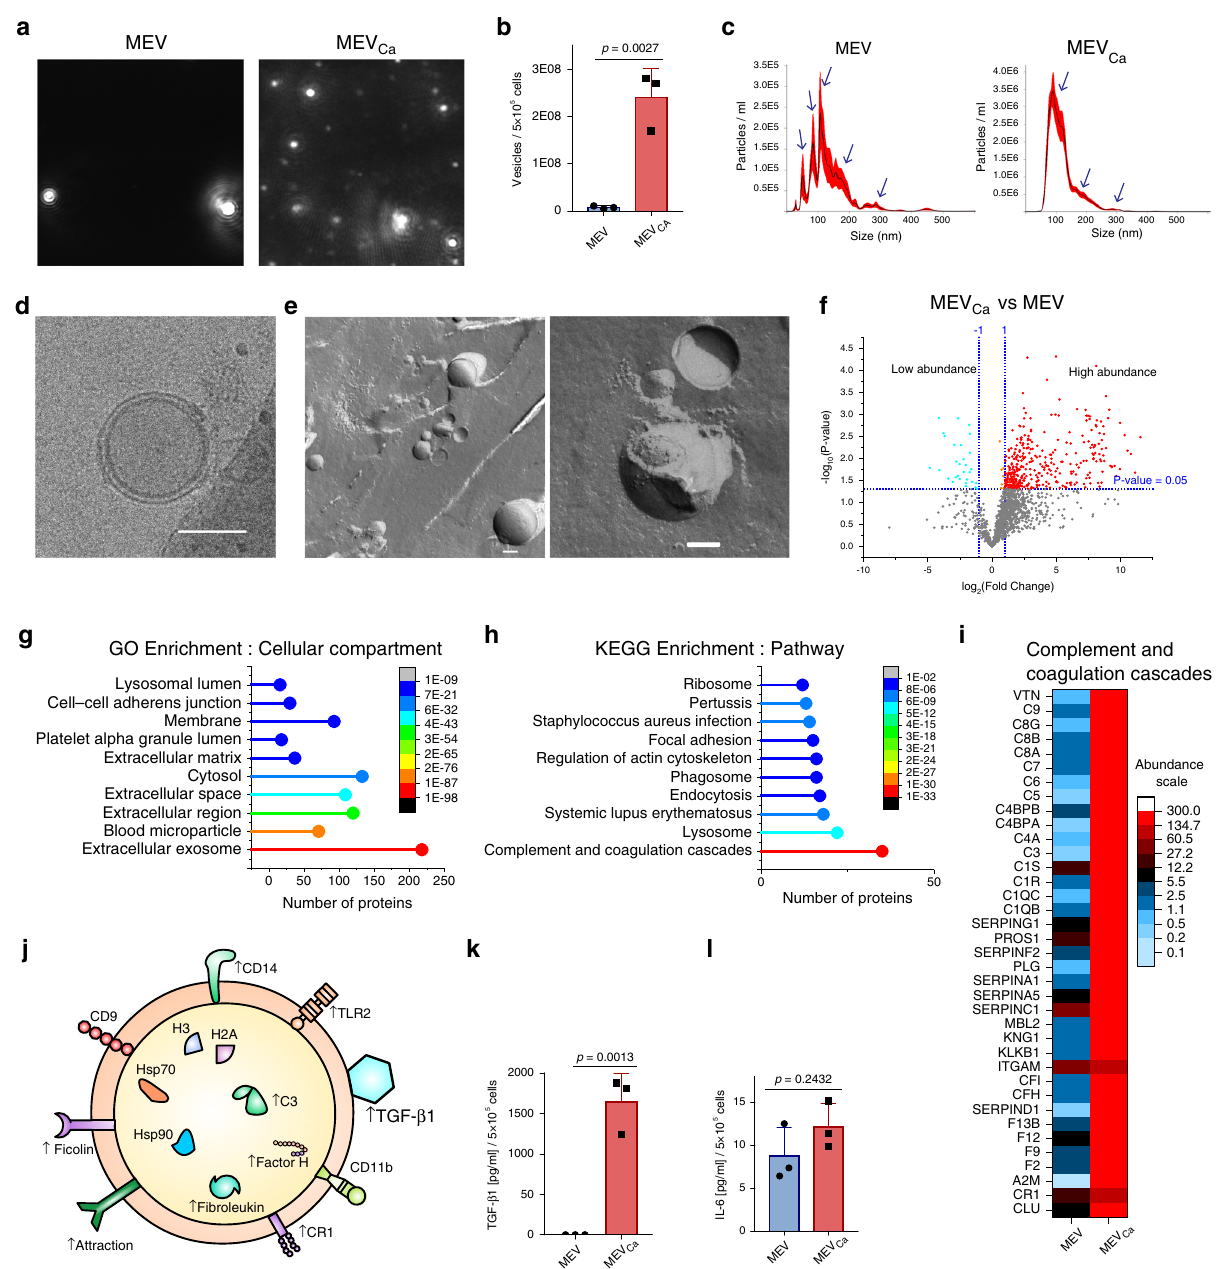
Fig. 2 MEV Cas are double-layered vesicles. a Tracking of EVs by dynamic light-scattering microscopy (DLSM). EVs were isolated from 5 × 10 5 uninfected or opsonized C. albicans -infected monocytes (MEVs or MEVs Ca , respectively) by polymer precipitation. Representative data of three independent experiments (three donors) are shown. b MEVs Ca are signi fi cantly increased compared with MEVs (data are presented as mean values + / − SD, p = 0.0027, unpaired two-tailed t test, n = 3 different donors). EVs isolated from same number of infected or uninfected monocytes were counted by DLSM.